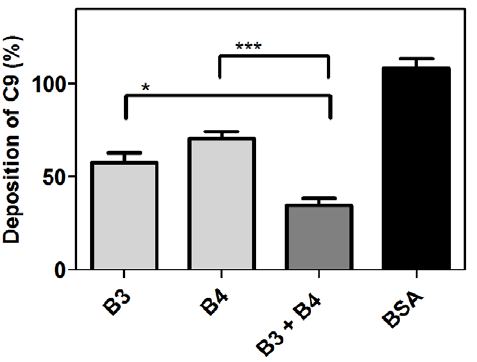
Figure 7. Additive effects of SMS B3 and SMSB4. Mannan was immobilized on microtiter plates and allowed to activate 4% NHS containing 5 m g/ml of either serpin (110 nM SMSB3 or 93 nM SMSB4) alone or mixed together. As a negative control BSA was used at a concentration of 10 m g/ml. After 20 min of incubation the plates were washed and the deposited C9 was detected with specific antibodies. An average of three independent experiments is presented with bars indicating means 6 SEM. *p , 0.05, ***p , 0.001 by t test (GraphPad Prism).